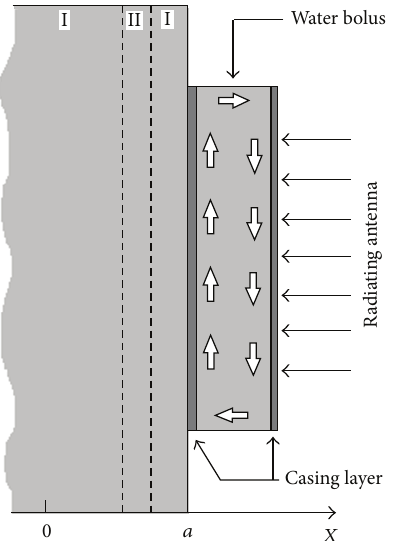
Figure 1: Schematic diagram of control zone. Cooling system consists of water bolus embedded in a casing layer which is placed between the applicator and biomedia. Regions I and II represent the healthy tissue and tumor region,